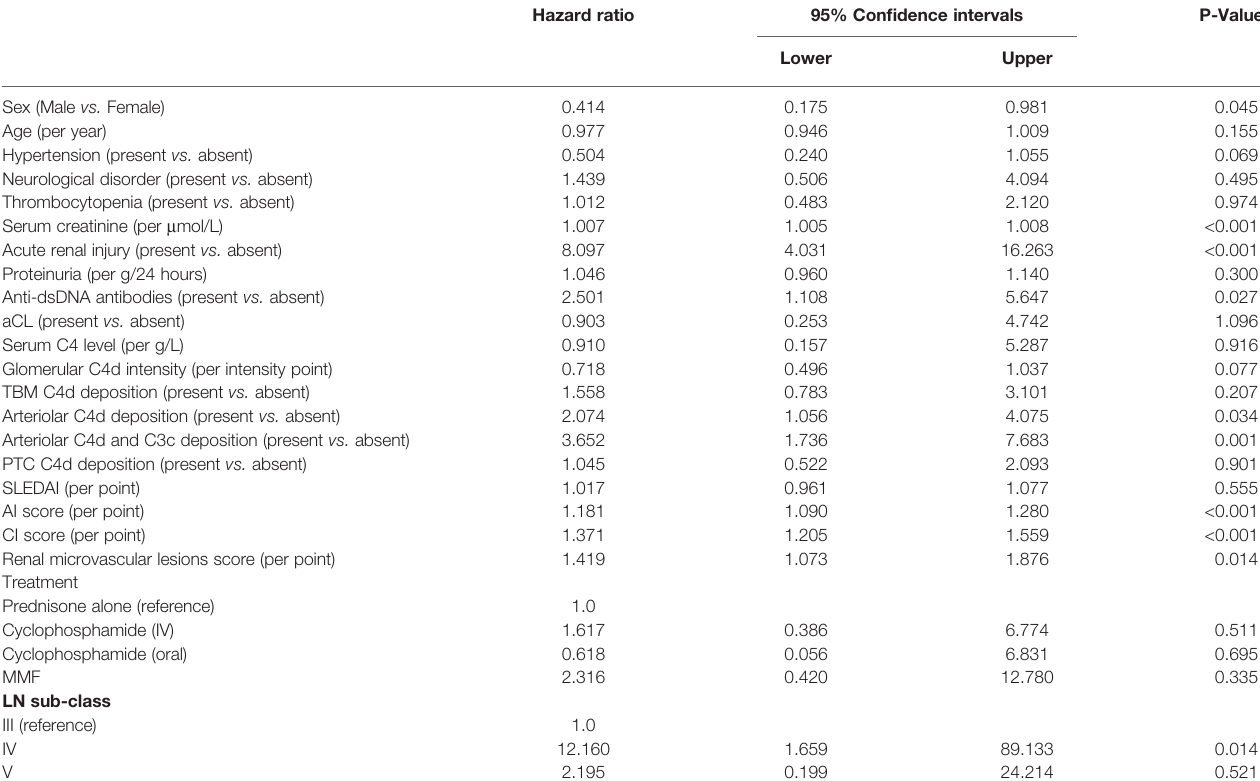
Hazard ratio 95% Con fi dence intervals P-Value Lower Upper